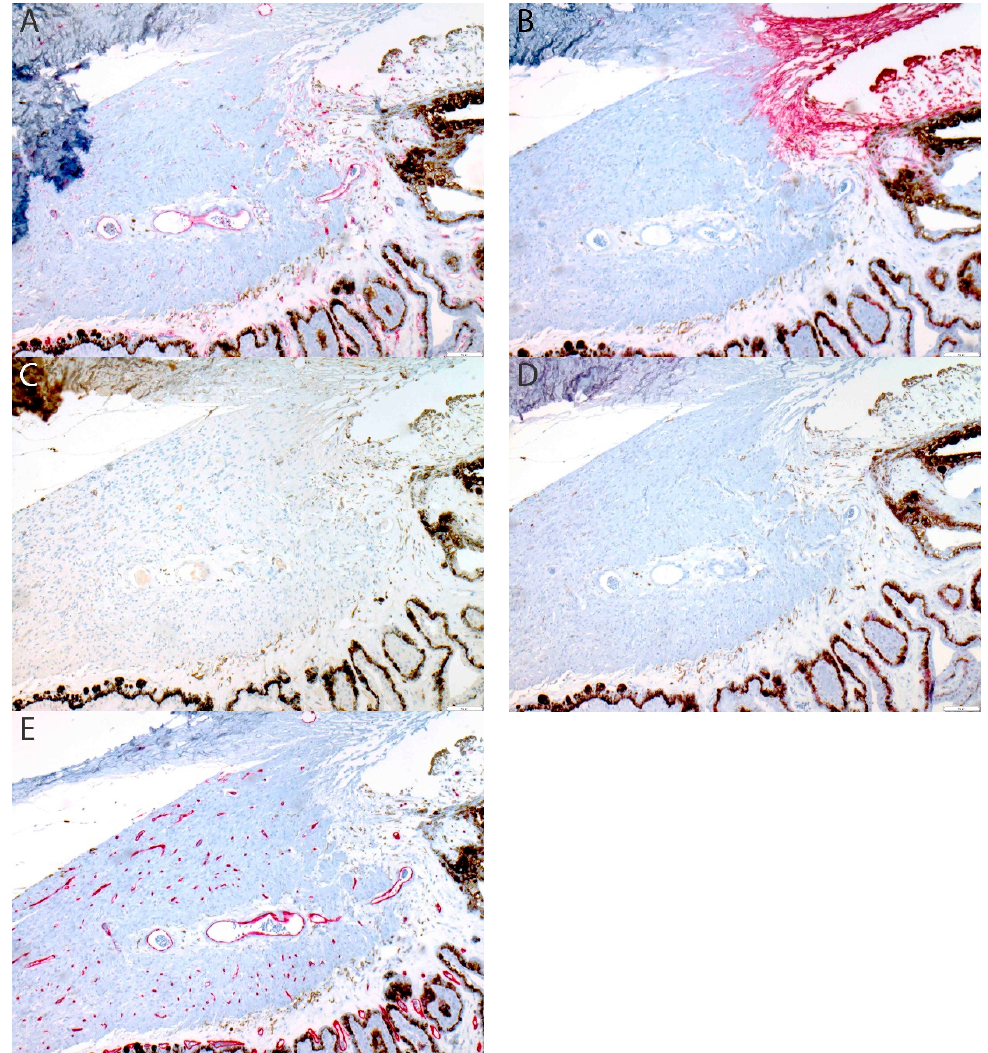
Figure A1. Positive staining of the trabecular meshwork, iris, and anterior ciliary body for podoplanin (D2-40) in an eye without uveal melanoma. ( A ) CD31 stains all vascular endothelial cells and shows focal positivity in macrophages. ( B ) D2-40 stains the stroma of the trabecular mesh work, iris, and anterior ciliary body and shows focal positivity in macrophages. ( C ) LYVE-1 is negative. ( D ) Prox-1 is negative. ( E ) CD34 stains all vascular endothelial cells. (All panels: original magnification 25 ×